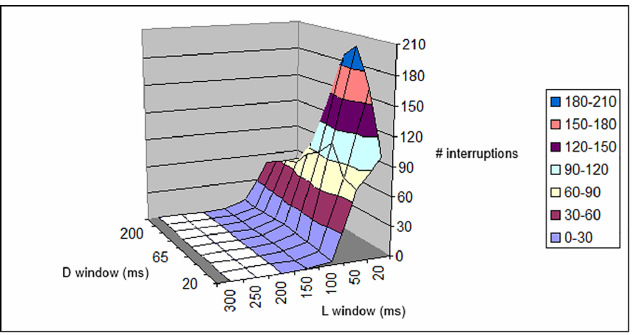
Fig 11. Plot of data given in Table 3. Number of interruptions with respect to L window and D window length, for a 5,000-ms period at 5,000 photons/s and a threshold of 6, as reported in Table 3.